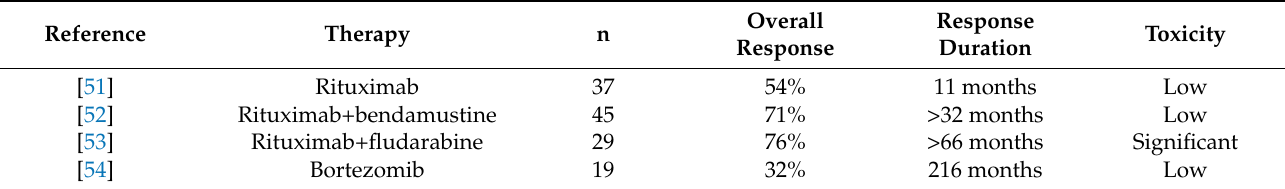
Table 4. Current recommended treatments for patients with